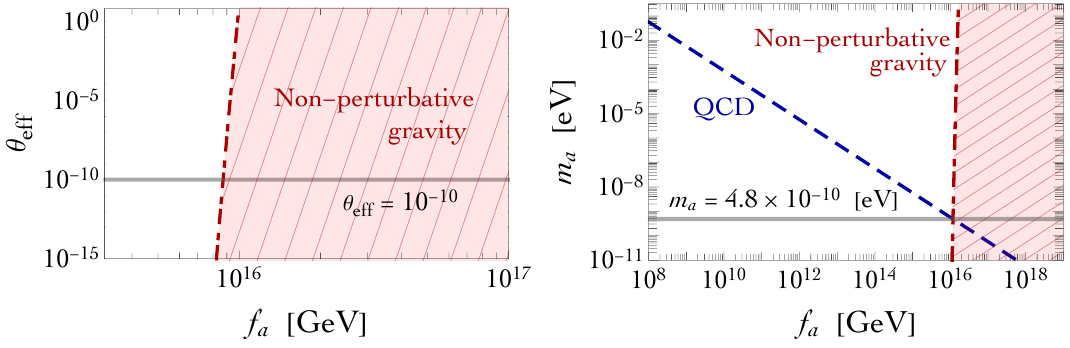
Figure 5 . Non-perturbative gravity corrections (red dot-dashed line) on (cid:18) e(cid:11) (left panel) and the axion mass m a (right panel) as a function of the axion decay constant f a . In the regions shaded in red non-perturbative gravity dominates. In the right panel, the dashed blue line represents the contribution to the axion mass generated by QCD, computed according to